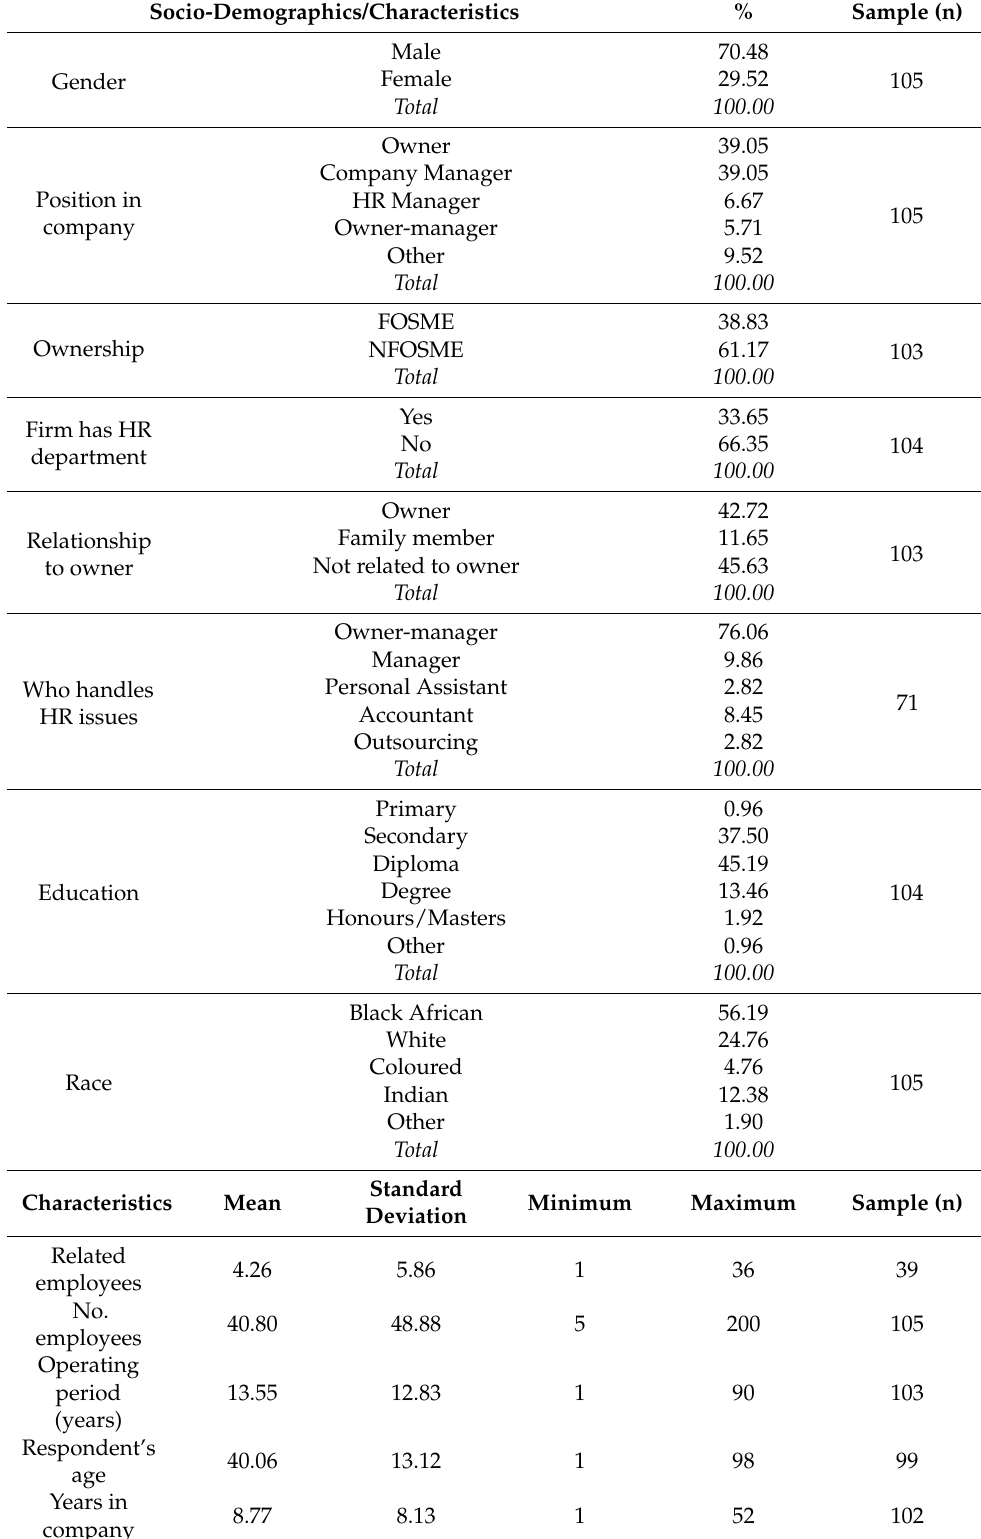
Table 1. Respondent’s socio-demographics and firm’s